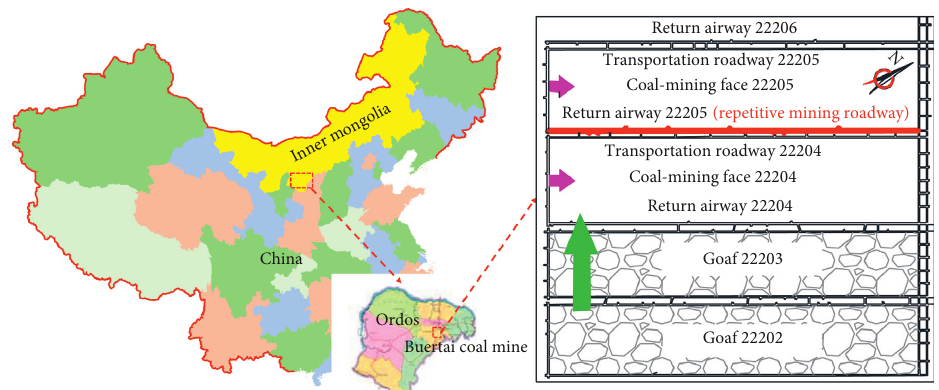
Figure 1: Return airway 22205 arrangement form in Buertai coal mine.